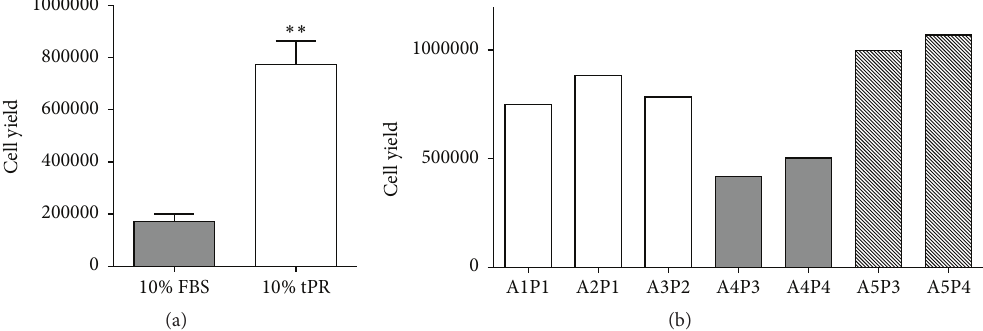
Figure 2: The effects of tPR on the growth of passage 0 ASCs. 100,000 freshly isolated SVF cells were plated and grown for ten days in either 10% FBS or 10% PR. (a) tPR treated cells yielded over four times as many cells after ten days in culture (𝑃 < 0.01) . (b) Various ASC lines at P0 (A1–A5) were treated with different tPR preps (P1–P4) to determine the variability different cell lines and tPR preps would have on cell